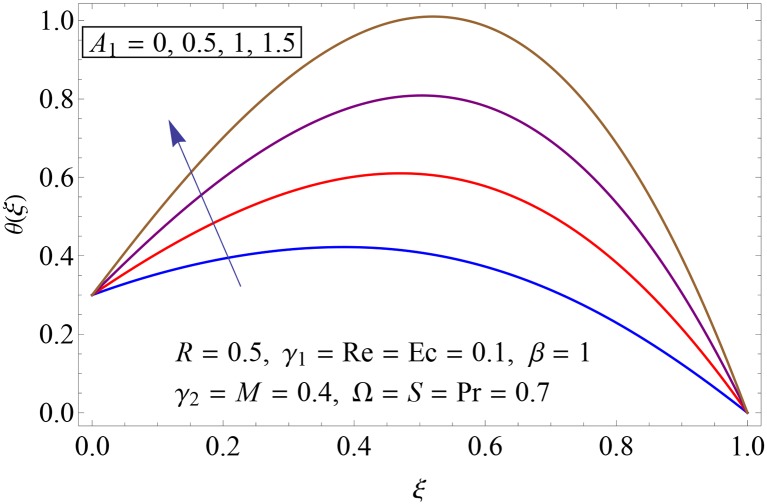
Impact of A1 on θ(ξ).